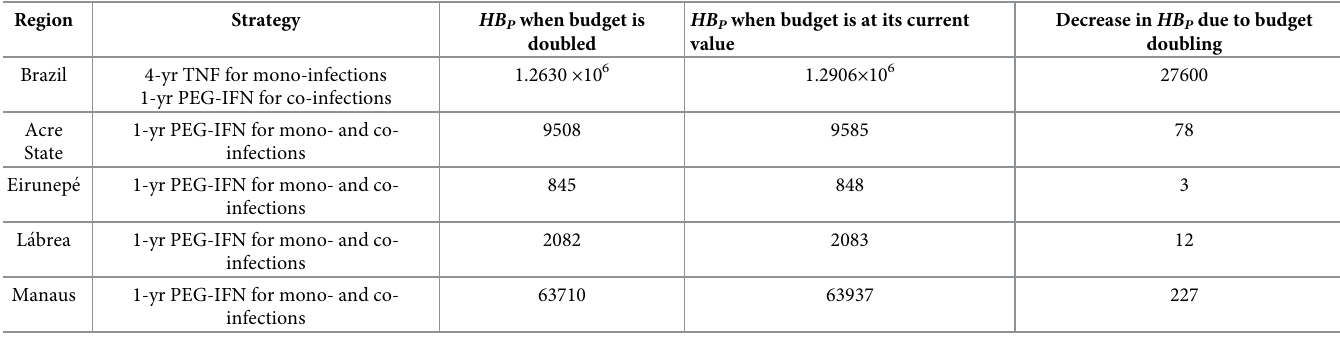
Table 8. Impact of budget doubling in Brazil at the national level and regional level on the number of HBV and HDV infections in 2027. Region